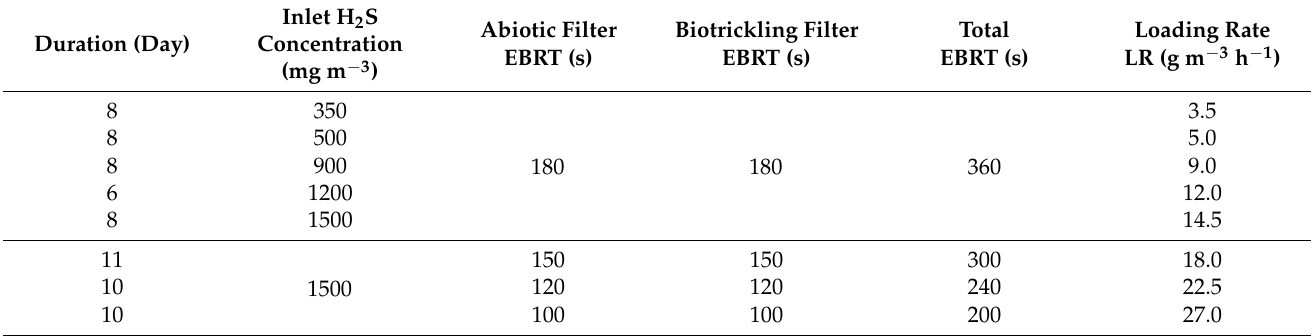
Table 2. Parameters used in this study.